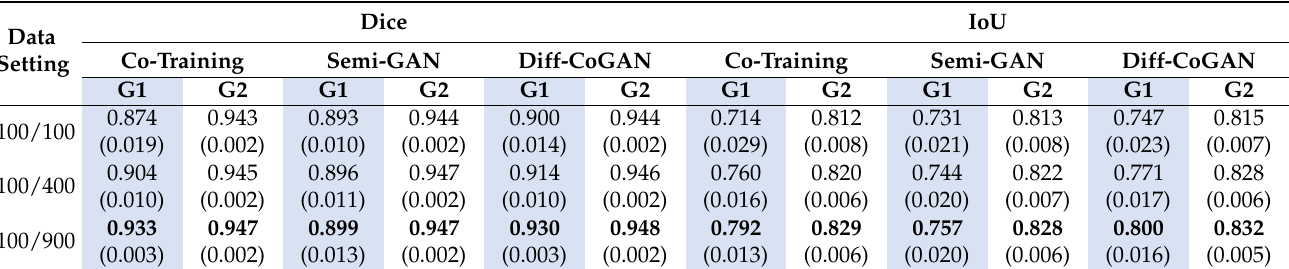
Table 8. The Dice and IoU values for the Spleen dataset. As more unlabeled data are added, the IoU values for all three models increase. Diff-CoGAN outperforms both co-training and semi-GAN due to the mutual guidance between the generators and the adversarial training of the two generators and the